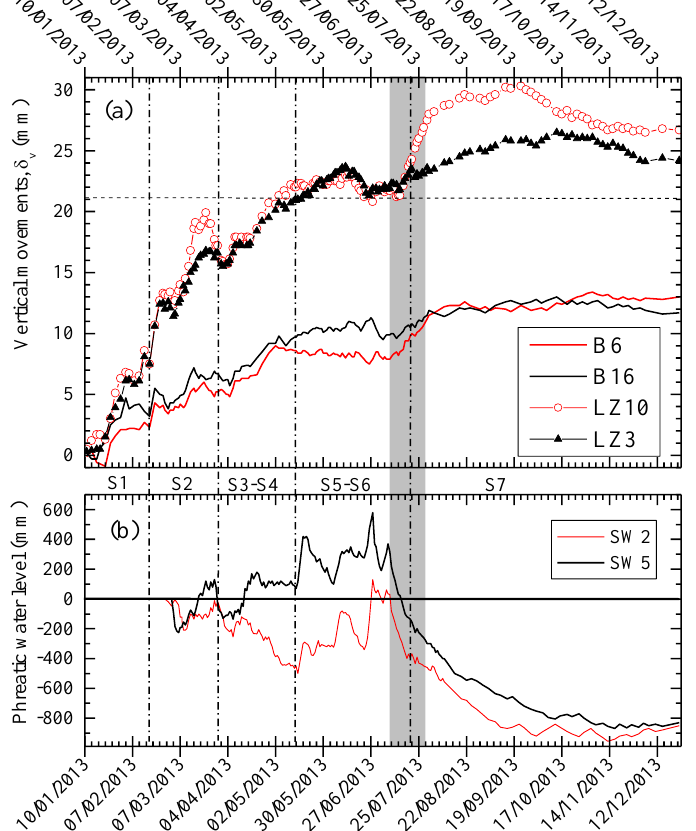
Figure 17. Developments of the monitored features against time: ( a ) vertical movements of the structures; ( b ) phreatic water level outside the pit.